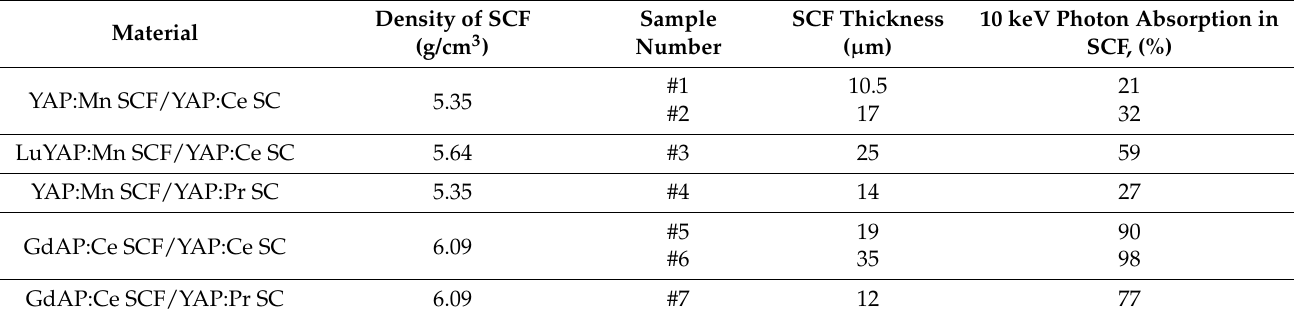
Table 2. Properties of the investigated samples.